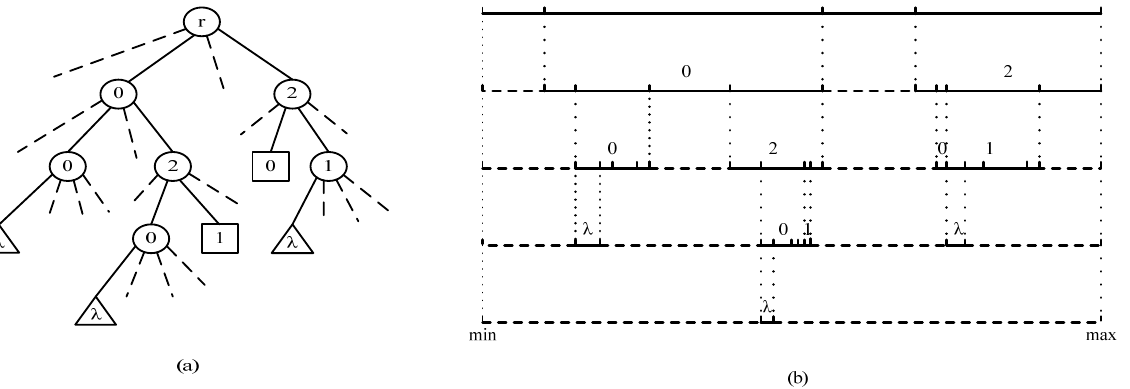
Figure 3. An example of OPRIT and the corresponding interval division results when M = 3. ( a ) is the encryption path, ( b ) is the interval division results.